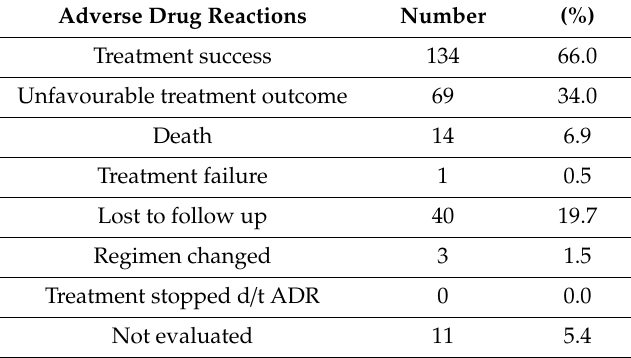
Table 3. Treatment outcomes of drug-resistant extrapulmonary TB cases in Delhi, 2016.